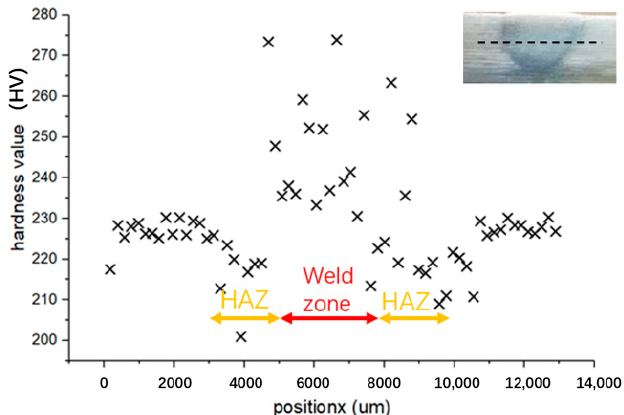
Figure 10. Microhardness profiles along X direction (nanowire